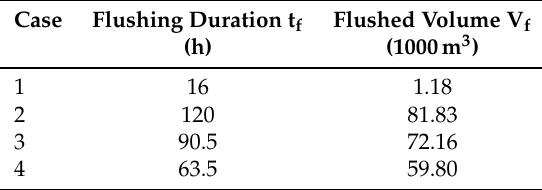
Figure 10. Extreme flood scenario: ( a ) boundary conditions for the extreme flood scenario and the four investigated regulation schemes; ( b ) simulated sediment flux at the outlet boundary for each case; and ( c ) longitudinal section of the mean riverbed in the reservoir for initial conditions (black) and the final situation for each case. Table 4. Comparison of the total flushed volume during the extreme flood